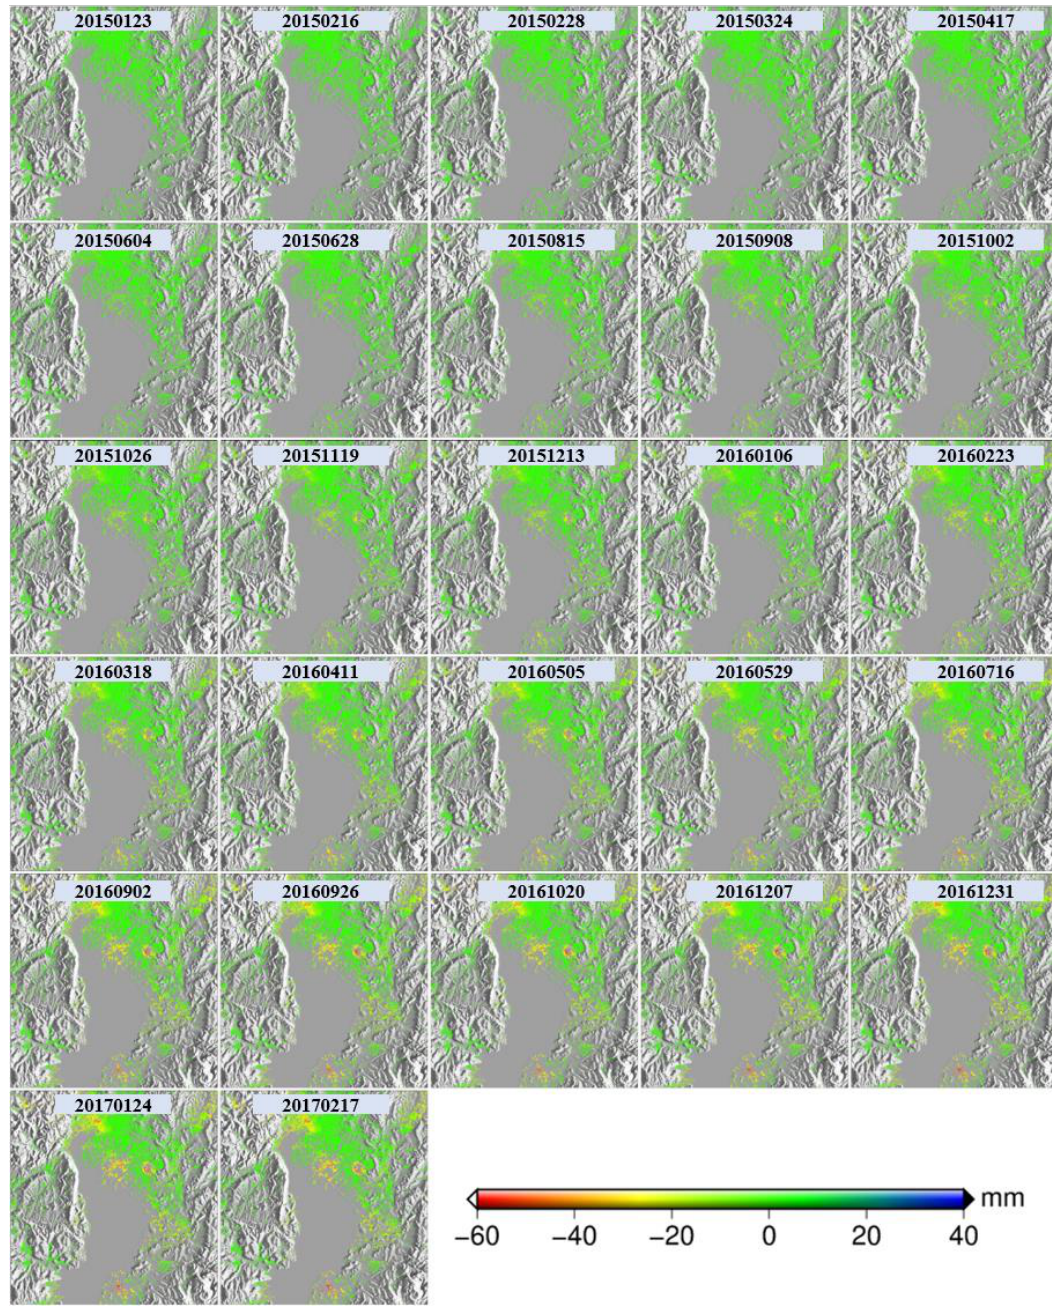
Figure A2. Time series deformation in Kunming observed using C-band Sentinel-1A images with ascending orbit between 23 January 2015 and 17 February 2017.